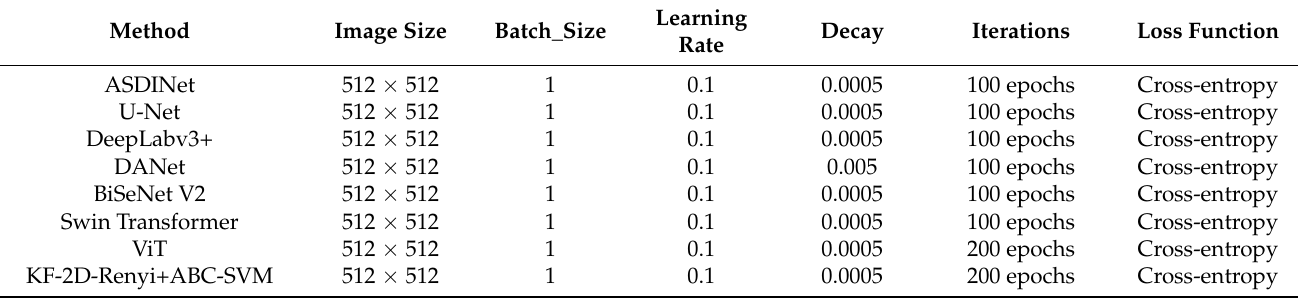
Table 8. Learning settings and